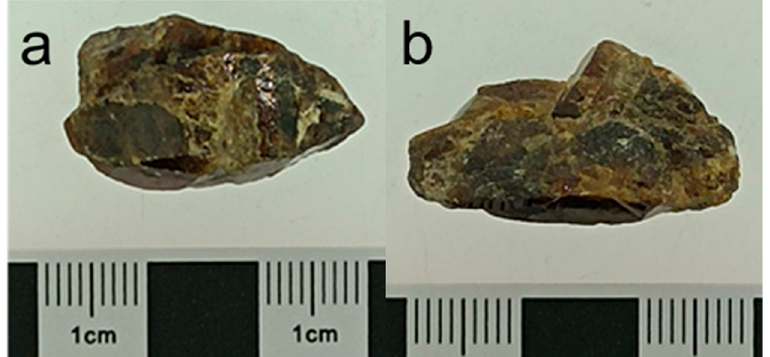
Figure 2. The titanite crystals of MG-5 ( a ) and MG-6 ( b ). The SG values of MG-5 and MG-6 are 3.51 and 3.56, respectively. Since the refractive index of titanite varied between 1.89 and 2.02, the index of refraction exceeded the refrac- tometer’s value and could not be measured. The titanite samples do not change colour under a Chelsea colour filter. The titanite samples have a rare earth spectrum, as seen through spectroscopes, with multiple fine absorption lines and 580 nm double lines.